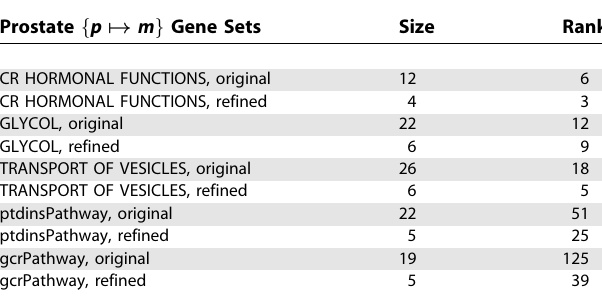
Table 6. Rankings of Original and Refined Gene Sets for the PCA to Metastatic State Transition Based on RML Prostate f p a m g Gene